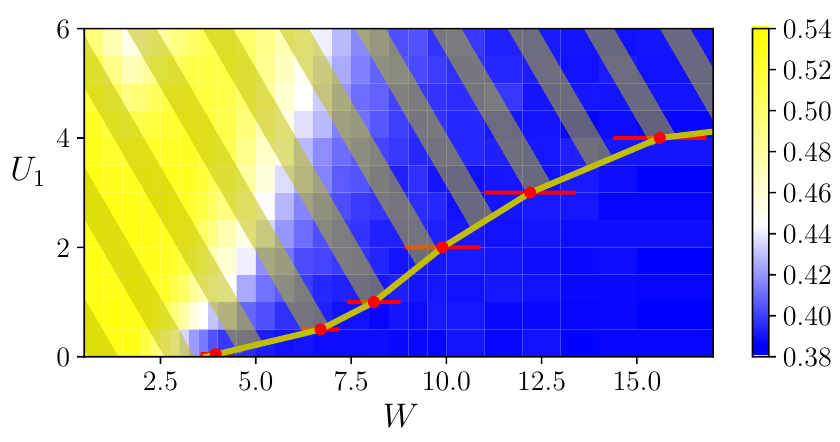
Figure 2: Contour plot of the mean gap ratio r as a function of random uniform disorder with amplitude W and of the long-range interaction strength U . The mean gap ratio is determined in the center of the spectrum (for 1 ε = ( E − E ) / ( E − E ) ≈ 0.5). The yellow and blue regions denote the n n min max min ETH and the MBL phase, respectively, for N = 8 fermions, K = 16 lattice sites, and short-range interaction strength U = 1. A finite-size scaling analysis (see text and Fig. 3) places the boundary between ETH and MBL at the solid yellow line connecting ( U ) . The error bars reported the markers, giving the critical disorder amplitude W C 1 on the markers result from the comparison of finite-size scaling studies performed for K = 16,18,20 and K = 14,16,18,20. The statistical errors for the color-map data points are well below 1% of their